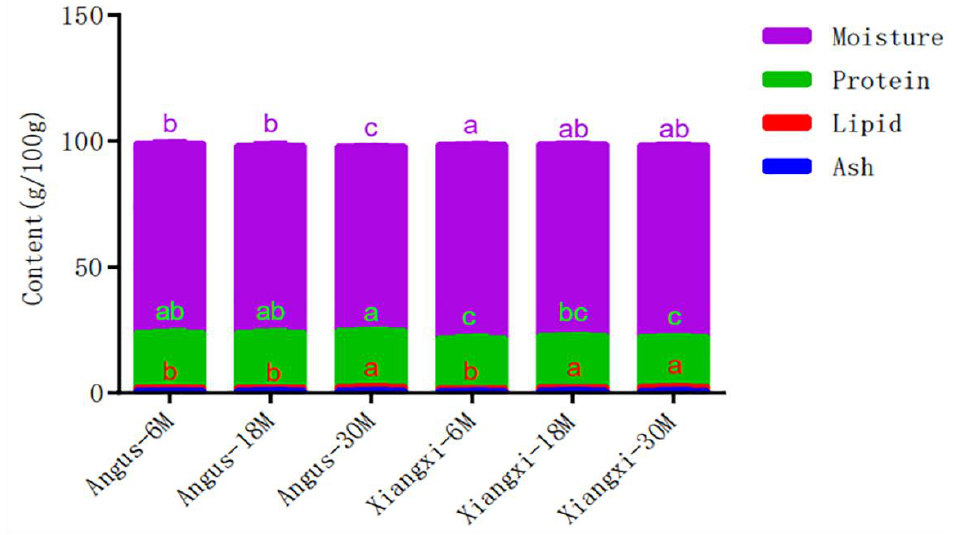
Figure 1. Proximate composition (g/100 g muscle) of LT muscle from Angus and Xiangxi yellow ca ttle. For the same ingredient, means lacking a common letter are significantly different ( p < 0.05).